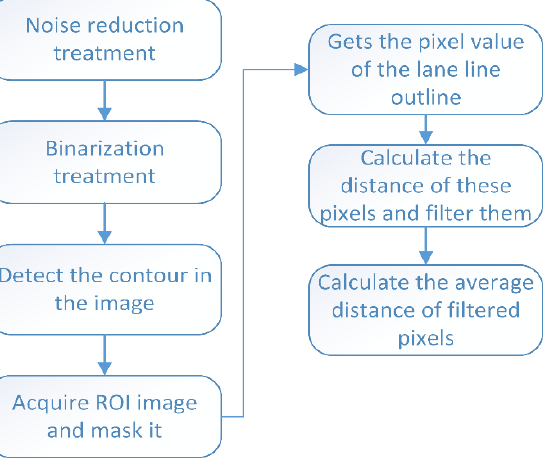
Figure 21. Flow chart of dynamic distance measurement using binocular camera.